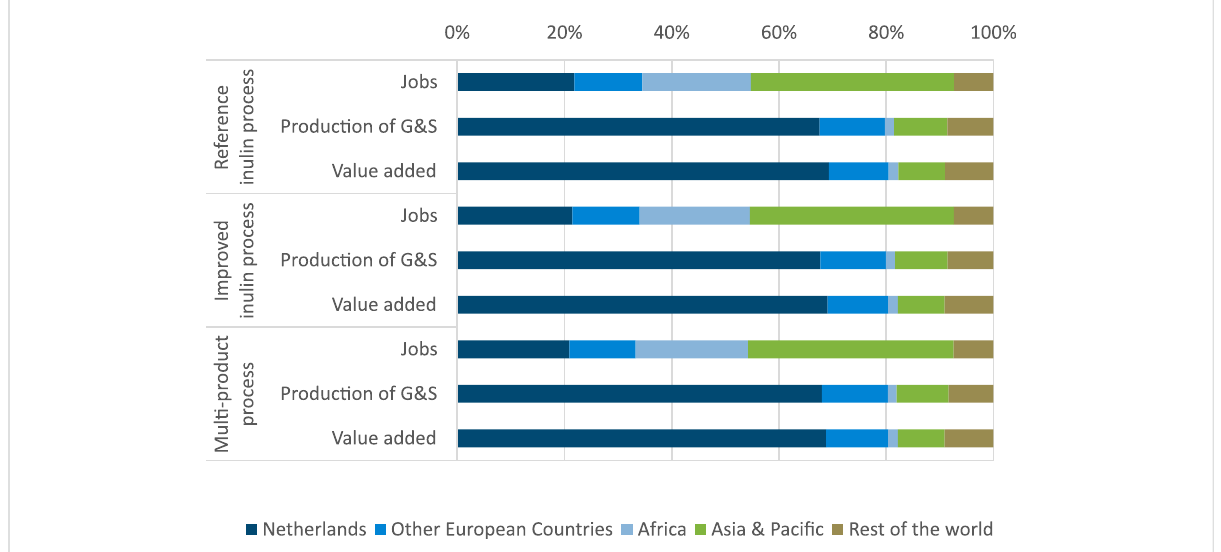
FIGURE 4 Distribution of indirect and induced impacts across